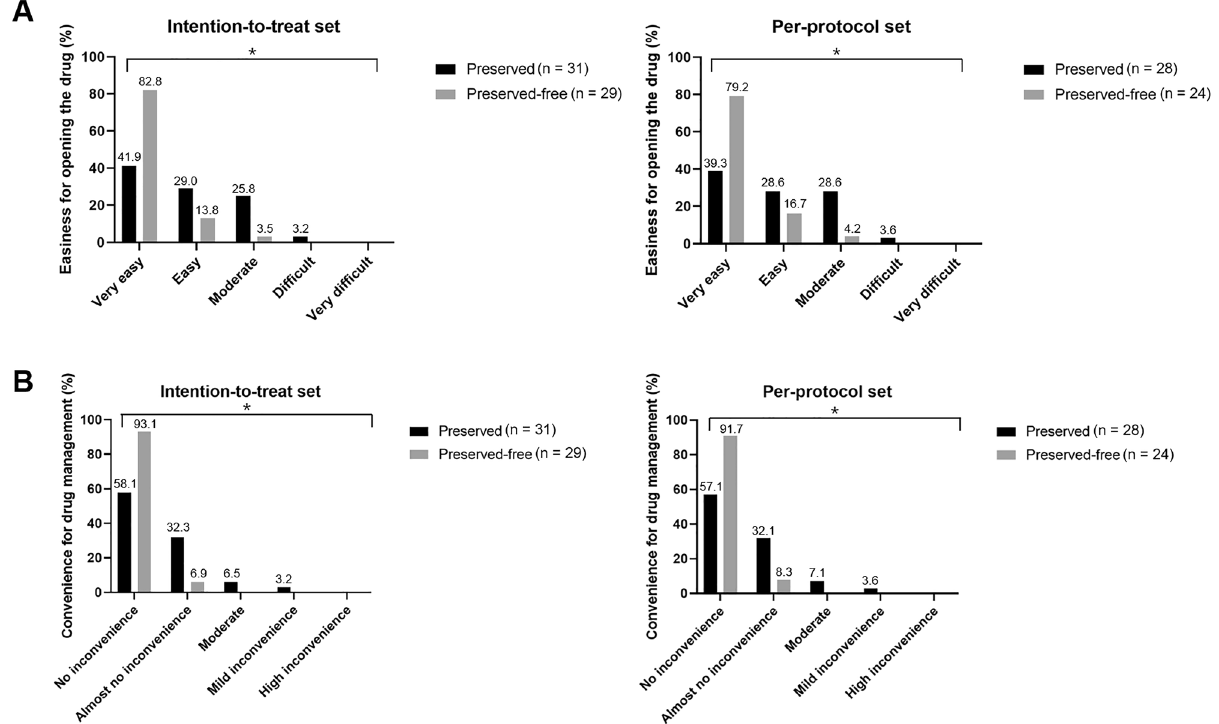
Figure 2. Proportions of patients surveyed regarding ( A ) the ease of opening the drug container and ( B ) the convenience of drug management. In both intention-to-treat (ITT) and per-protocol (PP) sets, significantly higher proportions of patients in the preserved-free group responded that it was very easy to open the drug container compared to preserved group ( P < 0.001 for the ITT group, P = 0.002 for the PP group). In addition, a significantly higher proportion of patients in the preservative-free group reported that the drug container type caused no inconvenience for drug management ( P = 0.002 for the ITT group and P = 0.005 for the PP group).